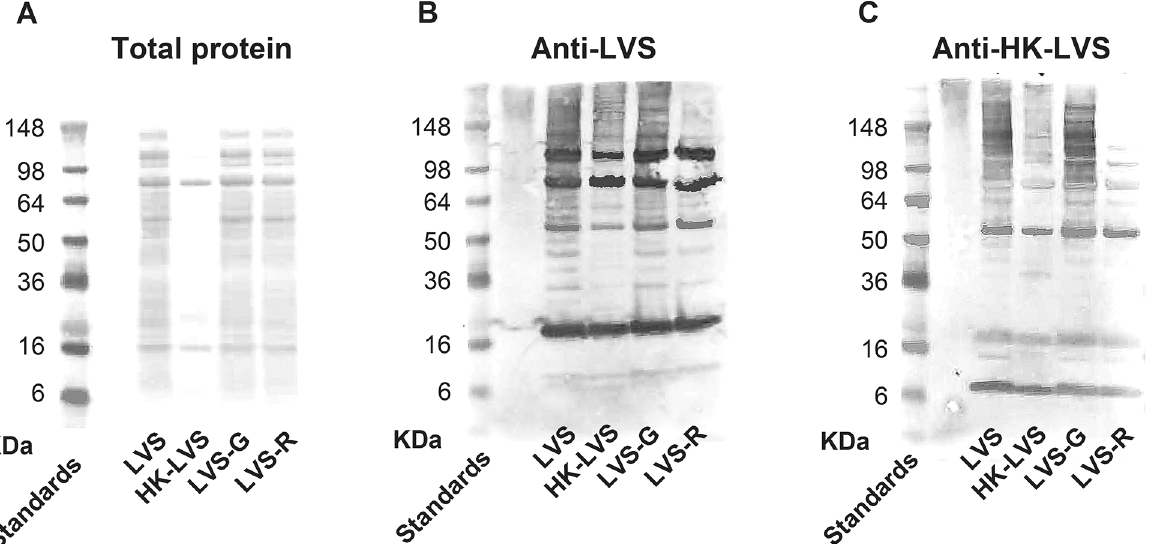
Fig 4. Protein staining and reactivity with serum derived from vaccinated mice revealed differences among vaccine extracts. Twenty μ g of protein extracts, prepared from whole LVS, HK-LVS, LVS-G, and LVS-R, were loaded on SDS-PAGE in reducing conditions and stained with Red Ponceau (Panel A). Following Ponceau staining, reactivity of protein extracts was analyzed by blotting the membranes with pooled sera derived from LVS vaccinated (Panel B) and from HK-LVS vaccinated BALB/cByJ mice (Panel C). Results shown are from one representative experiment of four independent experiments of similar design and